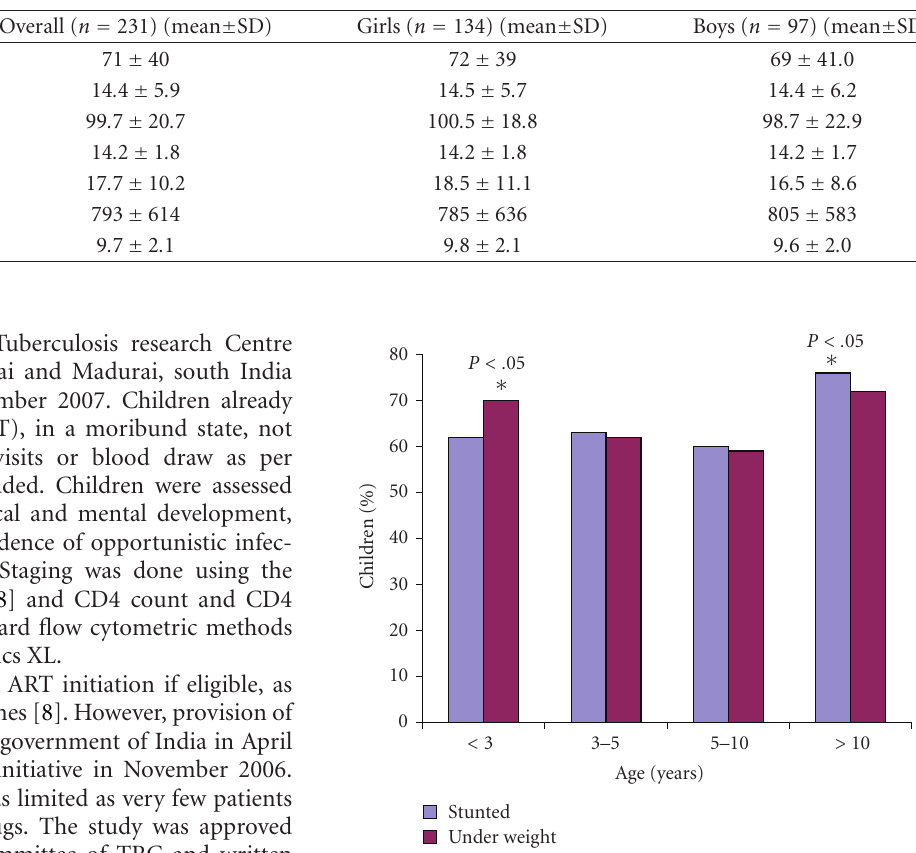
Table 1: Demographic profile of the study population.